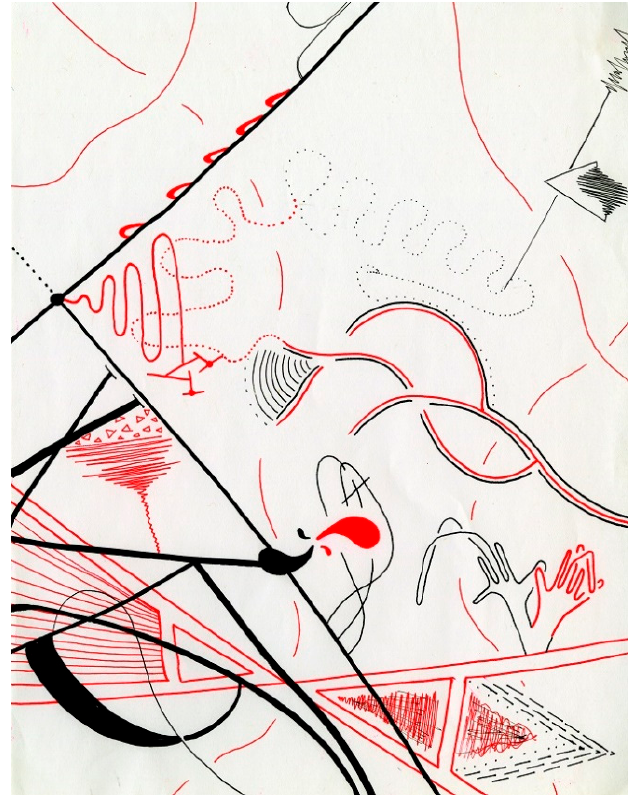
Figure A5. “Two Things”. Pure abstraction. Red and black pens, white paper. Drawing made by